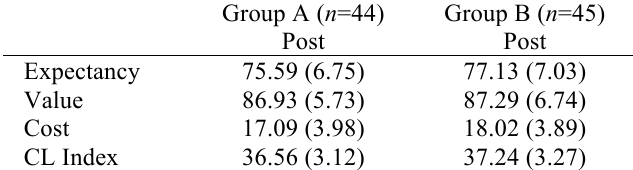
Descriptive Statistics of post-test for groups A and